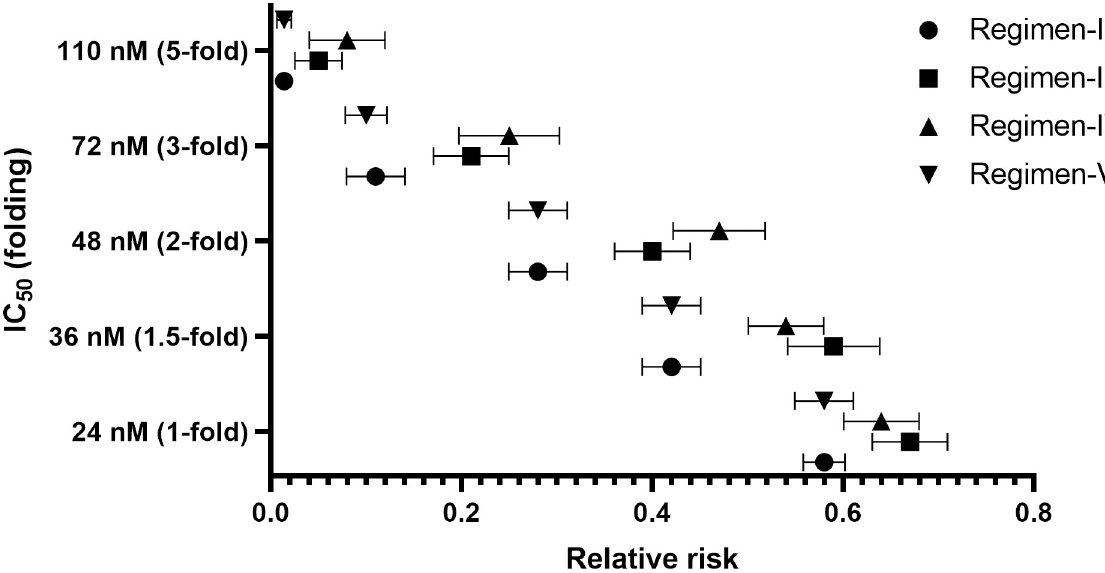
Fig 3. Comparisons of relative riskof different proposed regimens and IC50 values with 100% of adherence in patients with resistant mefloquine.